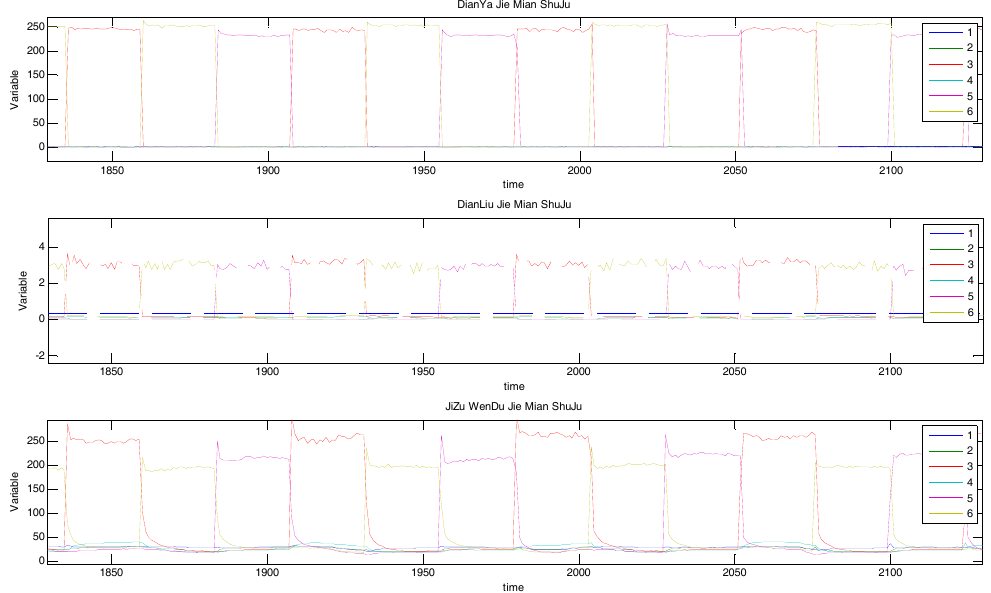
Figure 4. (2011.02.08~2011.02.13) Engines working curves when they automatically take turns. The first picture is the output voltage, the second is output current, and the third is exhaust temperature. Lines 1, 2, 3, 4, 5, and 6 represent six groups of engines, respectively.